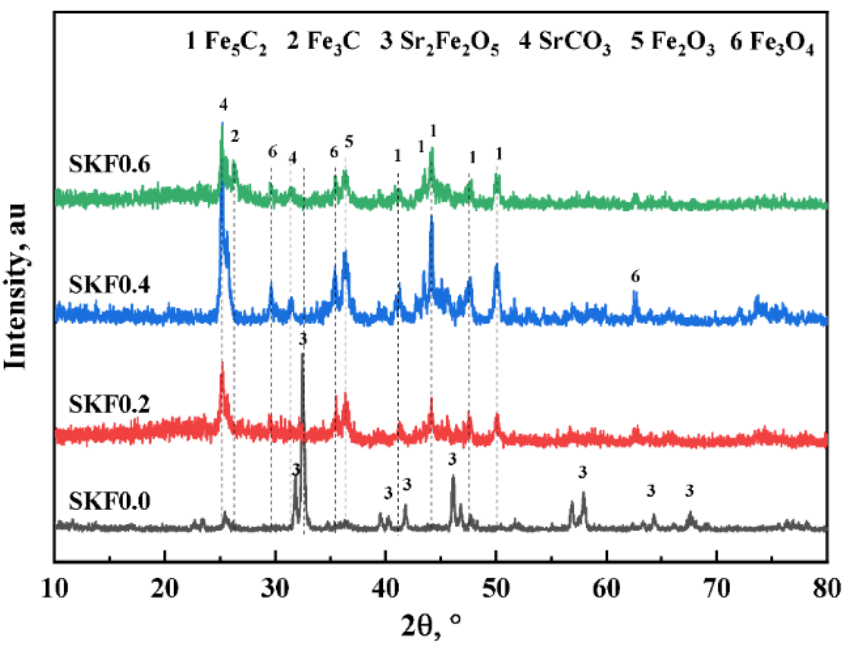
Figure 7. XRD patterns for the SKFx catalysts after reaction (H 2 /CO 2 = 3/1, 350 ◦ C, 1.0 MPa, GHSV = 7200 mL · gcat · − 1 · h − 1 ).